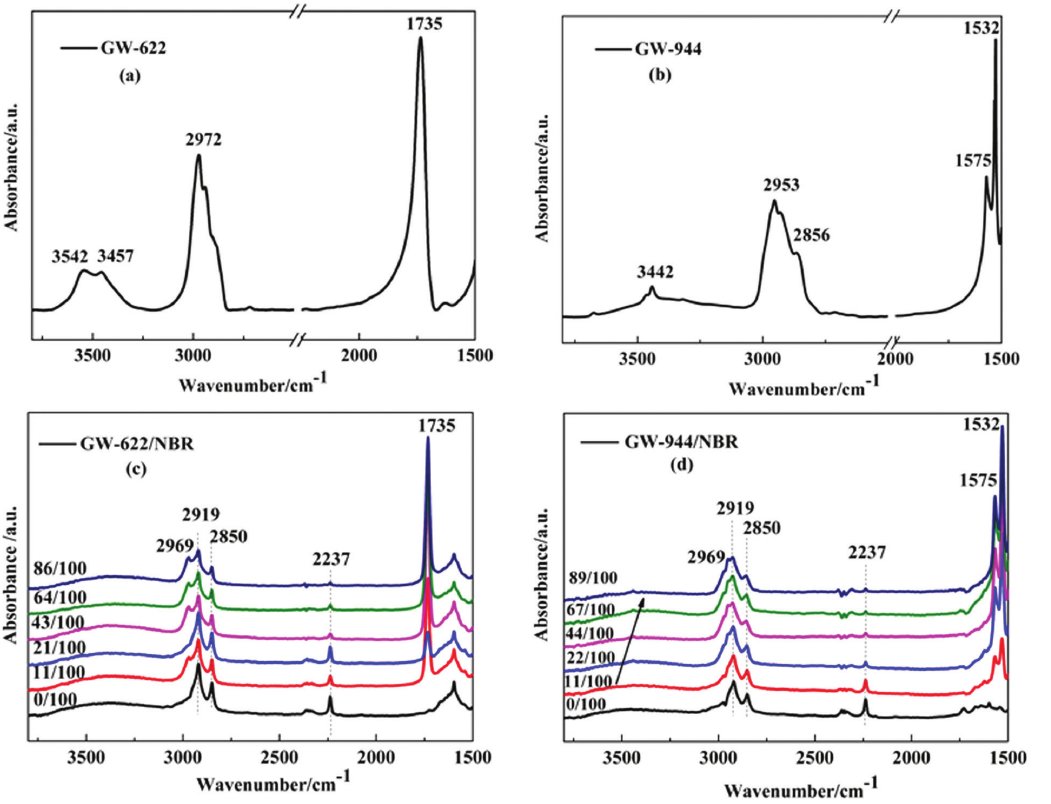
Figure 2: FTIR spectra of (a) GW-622, (b) GW-944, (c) GW-622/NBR and (d) GW-944/NBR composites with various